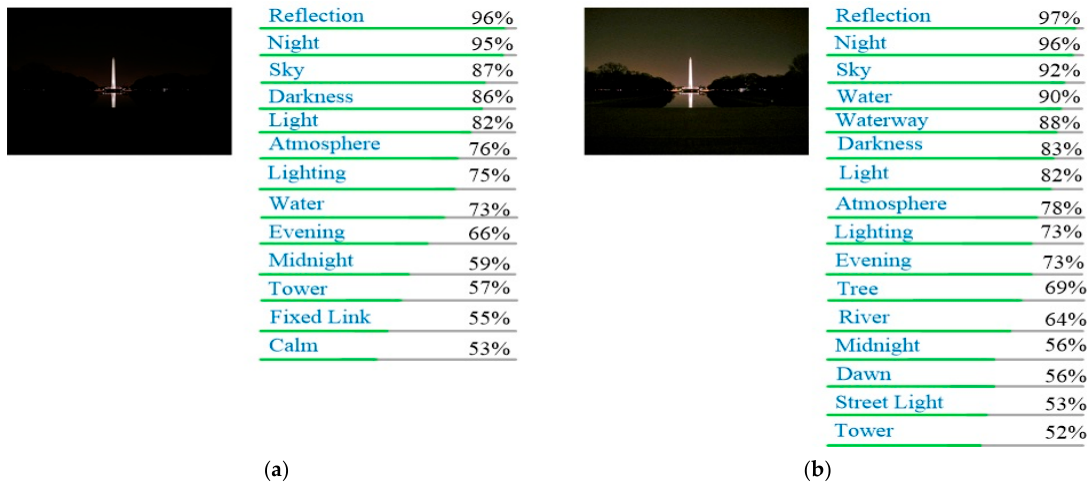
Figure 11. Results of Google Cloud Vision API for “27” from DICM dataset. ( a ) Recognizing result of